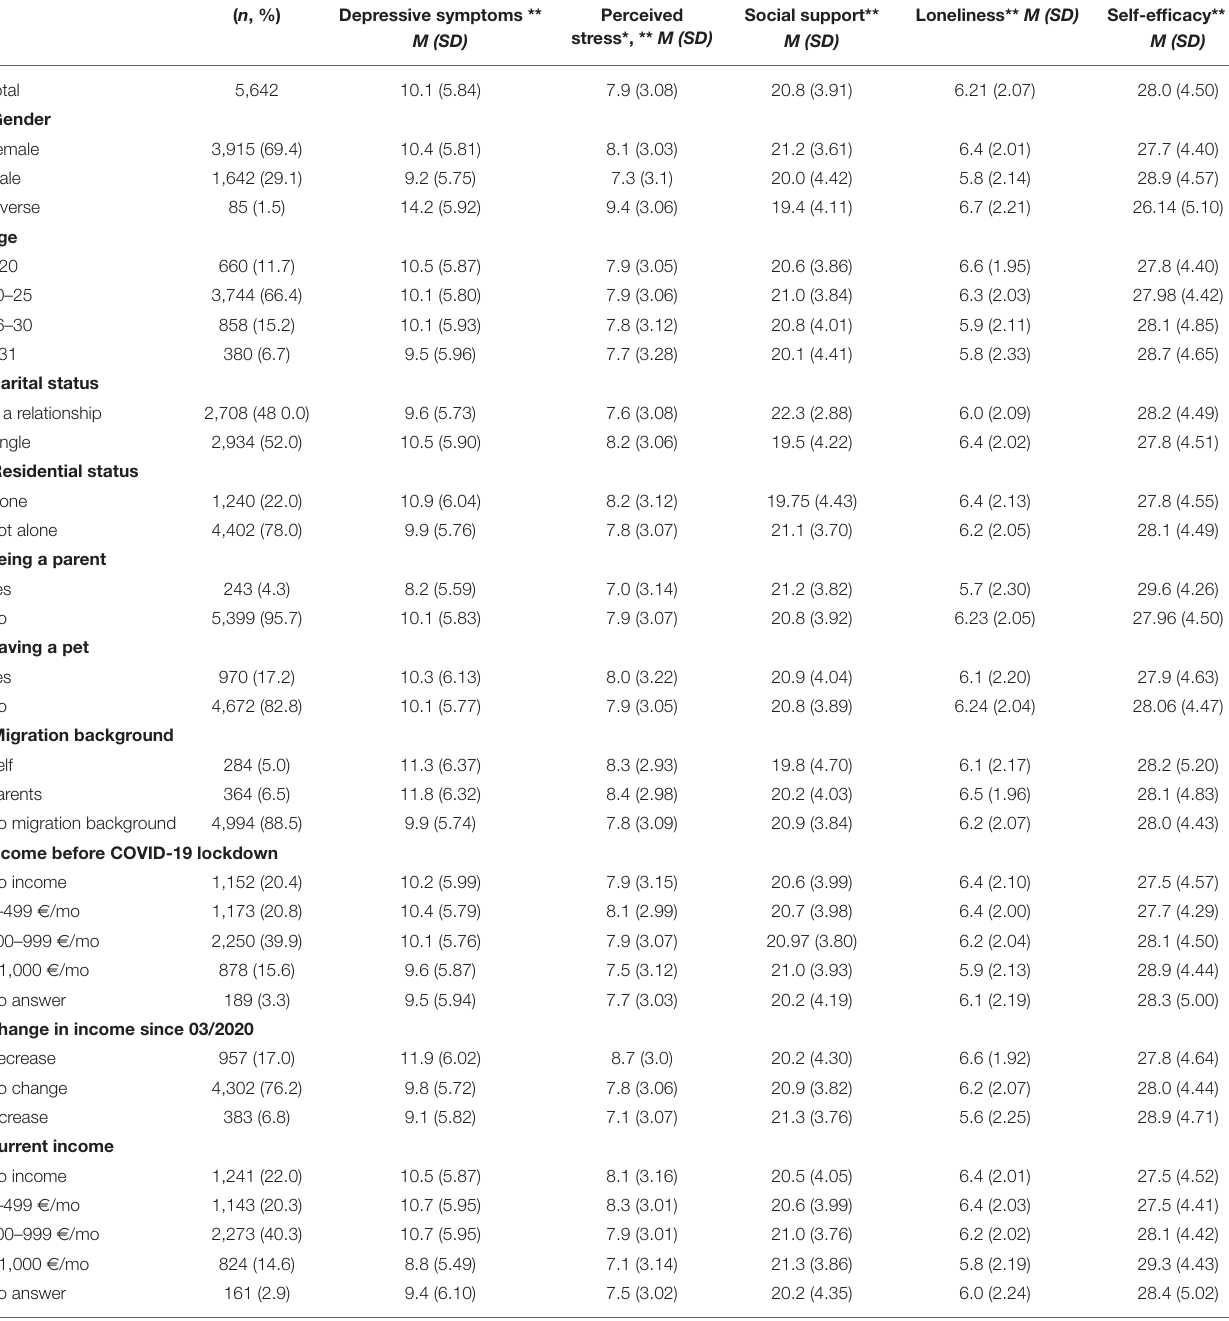
TABLE 1 | Characteristics of the total sample ( N =